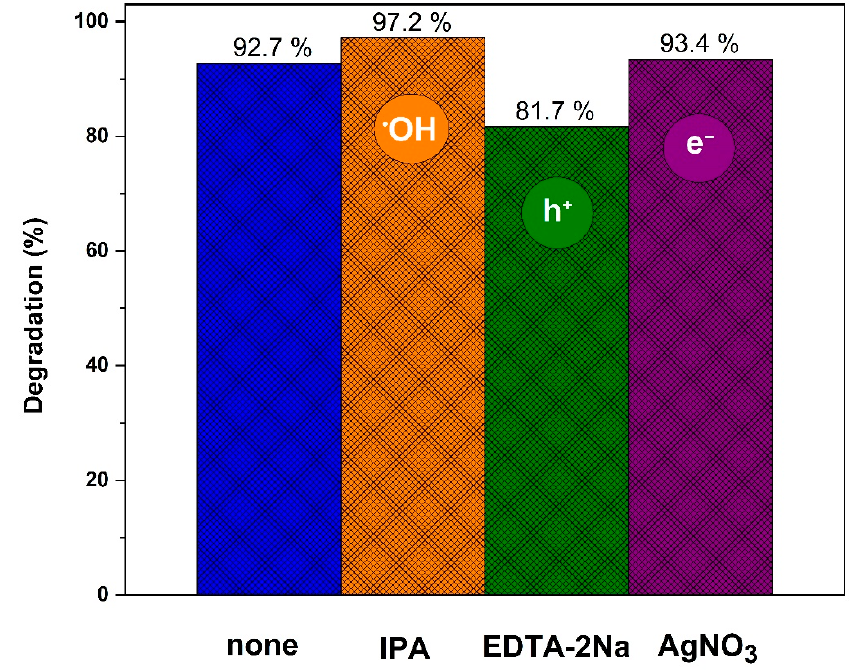
Figure 6. Effects of scavengers on the degradation of MB dye in milli-Q water with scavenger dosage of 0.01 mol L − 1 after 120 min of simulated solar irradiation.